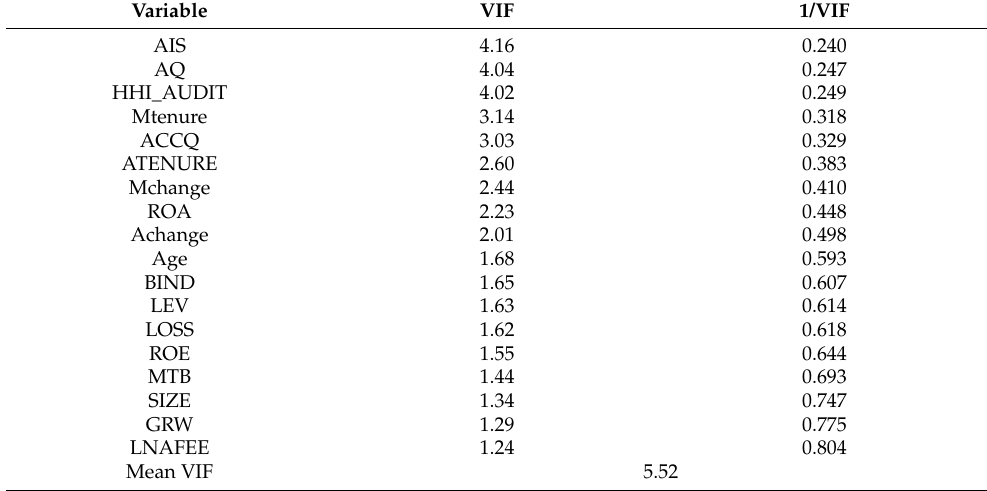
Table 4. The collinearity test